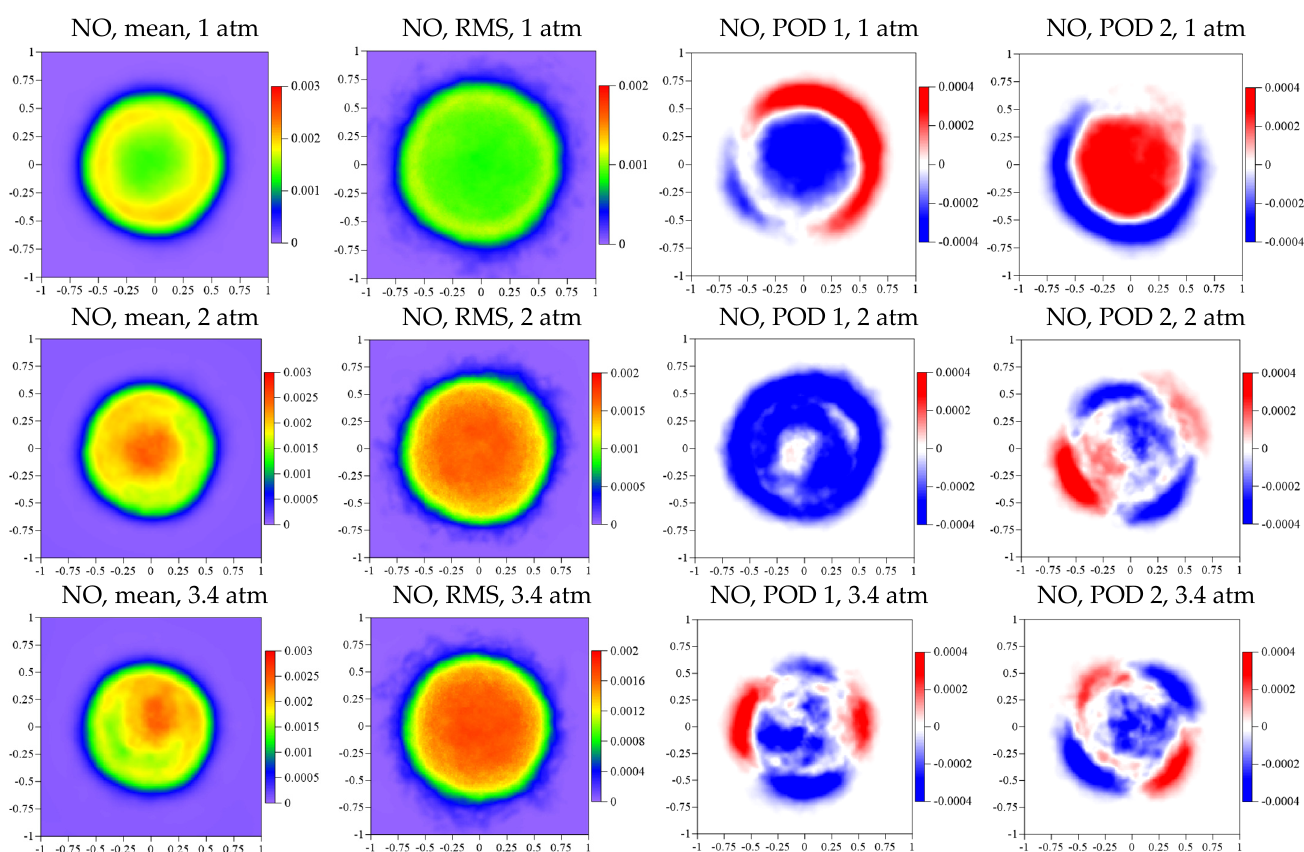
Figure 21. Mean and variation in the NO concentration field and the first and second POD modes.